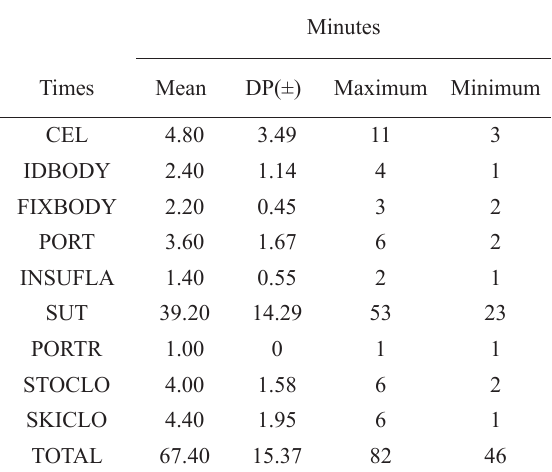
Operative times (minutes) to perform the single-port intragastric sleeve by endoplication technique in